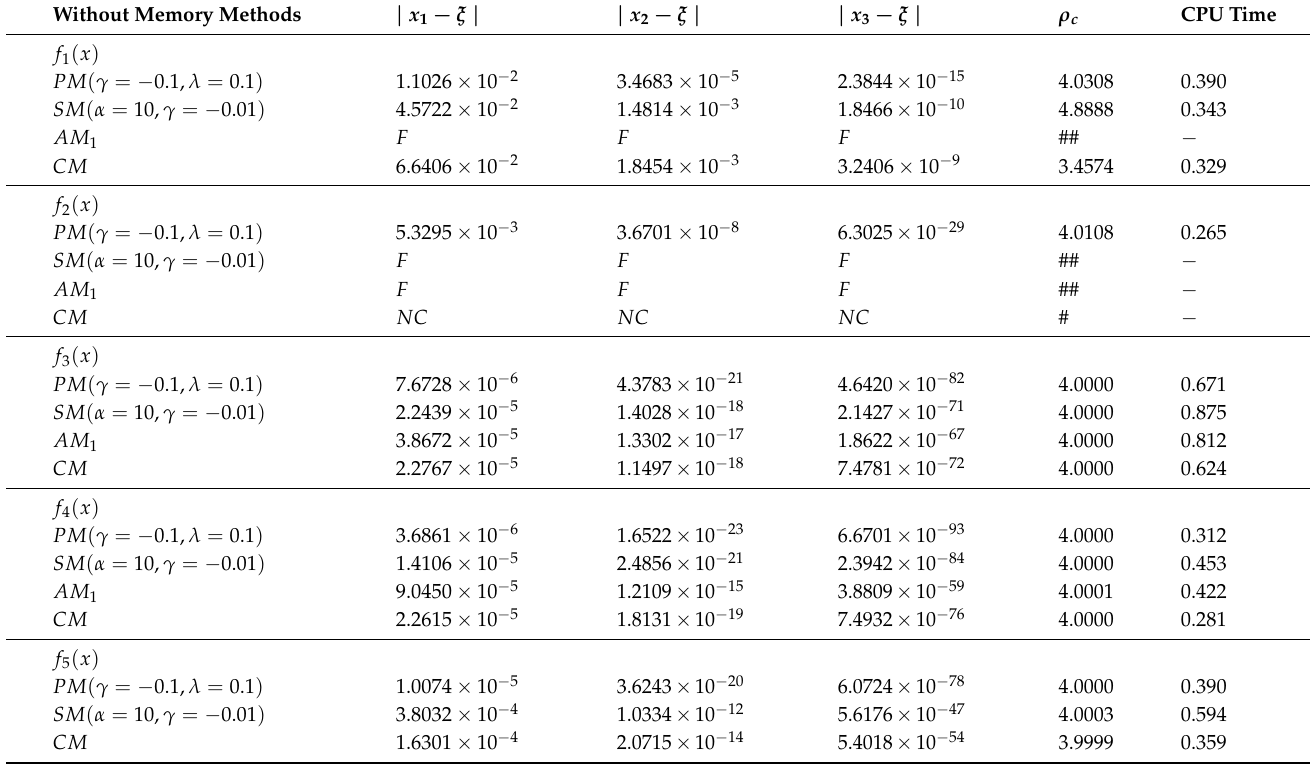
Table 2. Comparison of the different methods without memory.